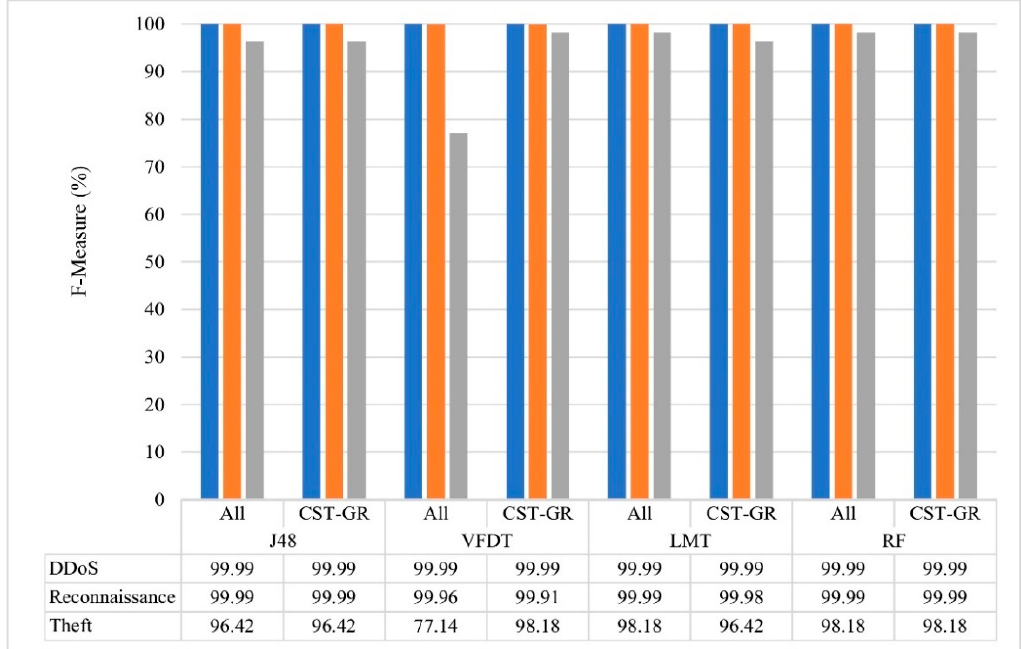
Figure 7. A comparison of F-measure of J48, VFDT, LMT, and RF between the cases using all features or using CST-GR selected features for each kind of attack.